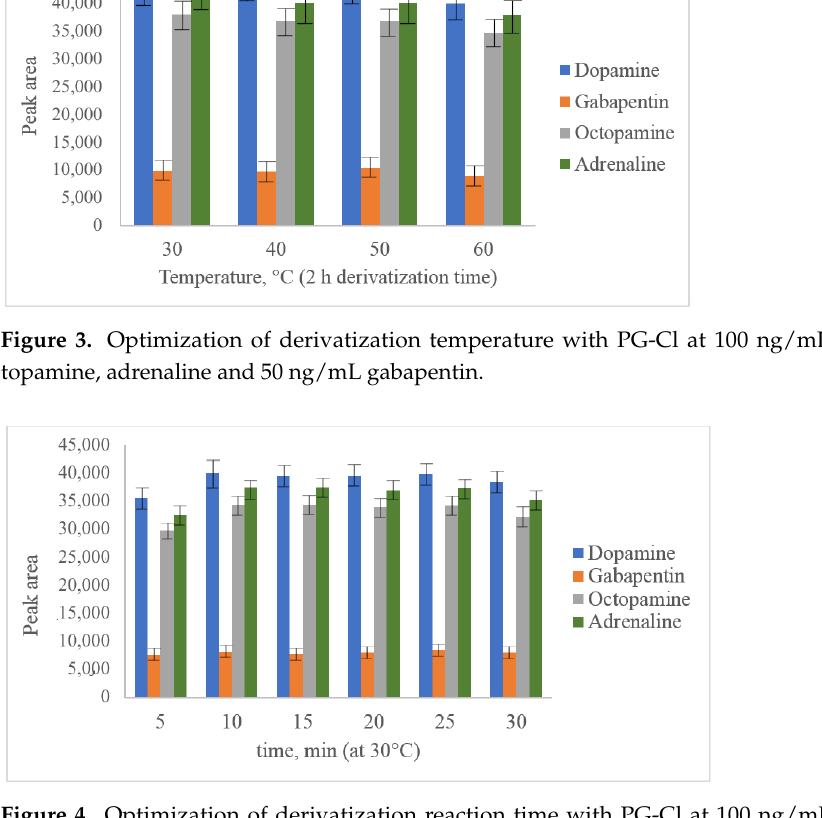
Figure 4. Optimization of derivatization reaction time with PG-Cl at 100 ng/mL dopamine, octopa- mine, adrenaline and 50 ng/mL gabapentin.